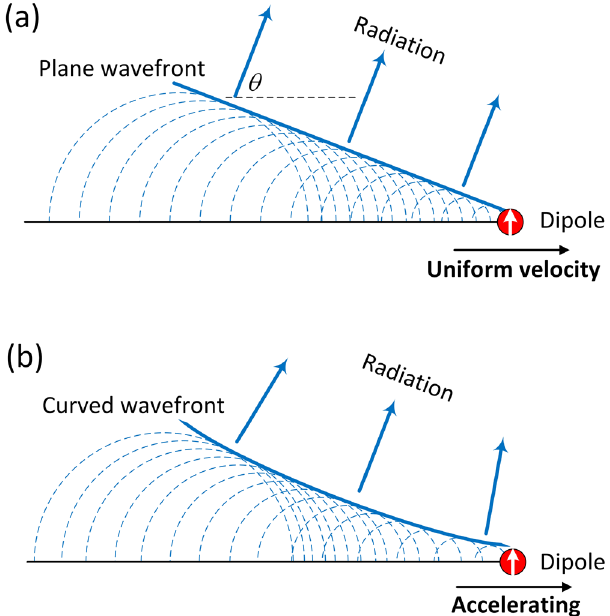
Figure 1. Schematic illustration of the process leading to the emission of Cherenkov radiation. The induced dipole moves with a uniform velocity ( a ), or in an accelerating fashion ( b